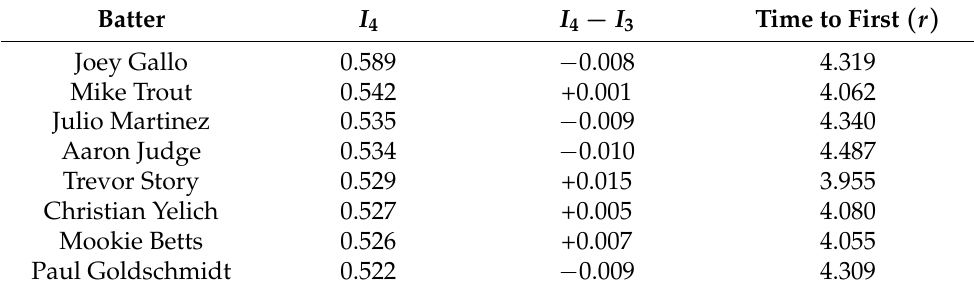
Table 4. Weighted on base average (wOBA) tesseract ( I 4 ) leaders for 2018, difference between wOBA cube and wOBA tesseract values ( I 4 − I 3 ) , and time to first ( r ) in seconds.